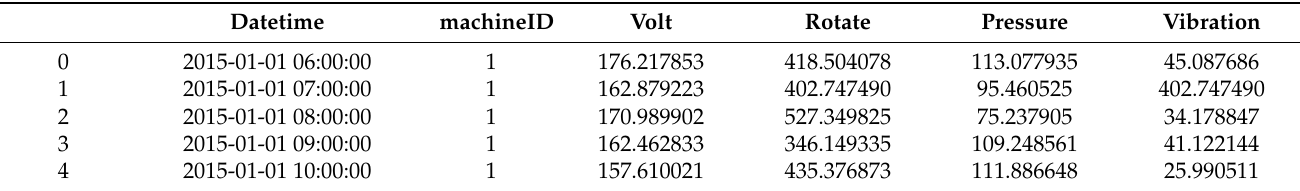
Table 1. Typical example of real-time telemetry recording.